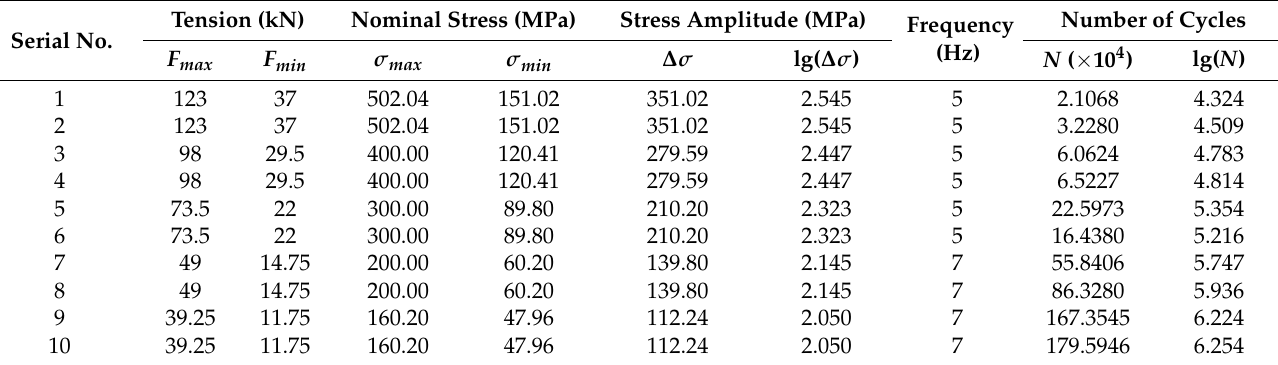
Table 2. Test results of constant amplitude fatigue of M20 torque shear high-strength bolts without